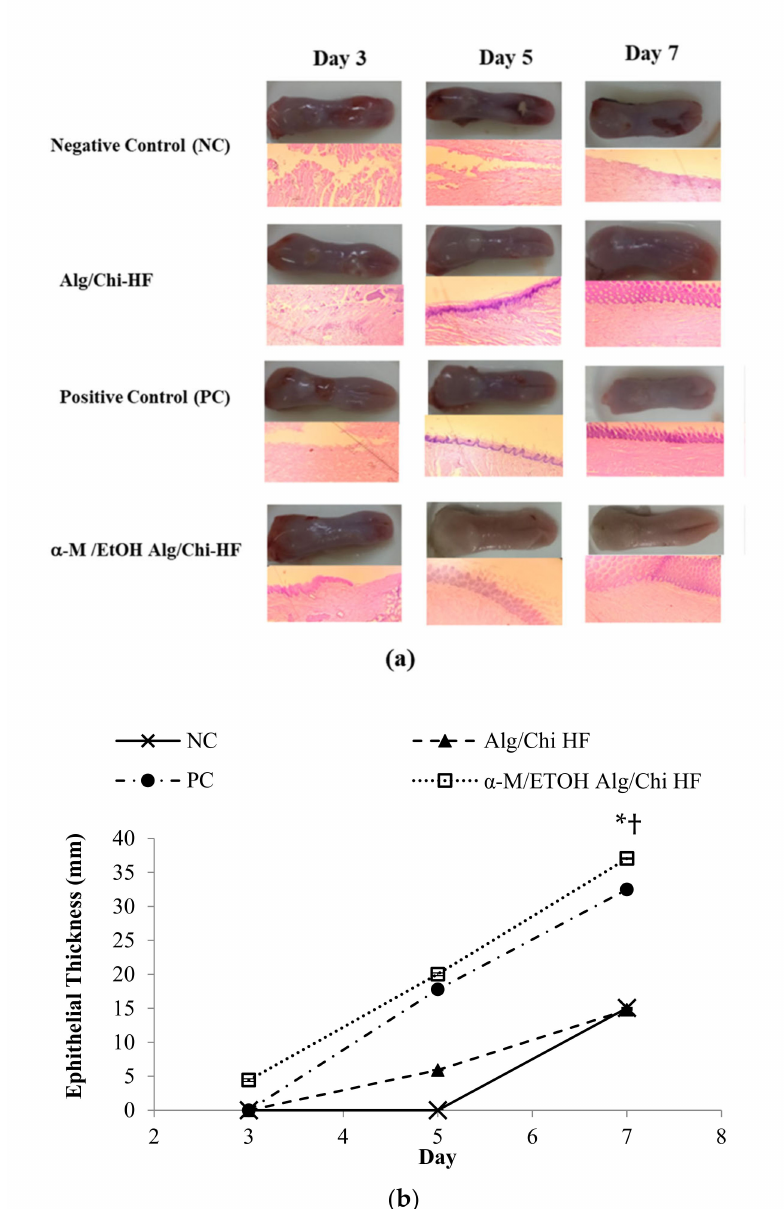
Figure 9. Histopathology study of tongue from treatment group of in vivo study ( a ). The in- crease in epithelial layer thickness in 7 days ( b ). Each value represents the mean ± SD of three experiments., * p < 0.05, compared to the PC, † p < 0.0001, compared to Alg/Chi HF and